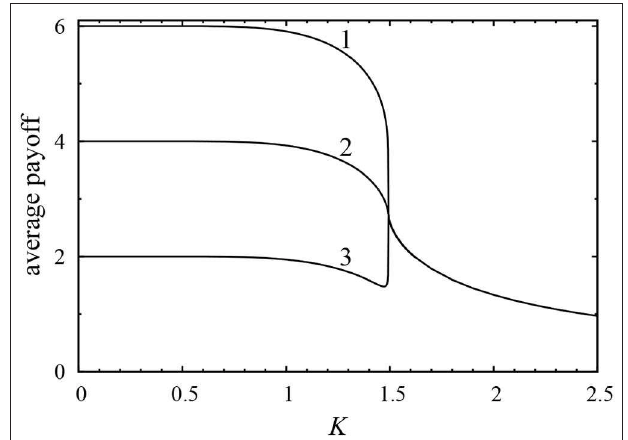
γ 3 0.5, γ 2 0). The labels above the = − = =